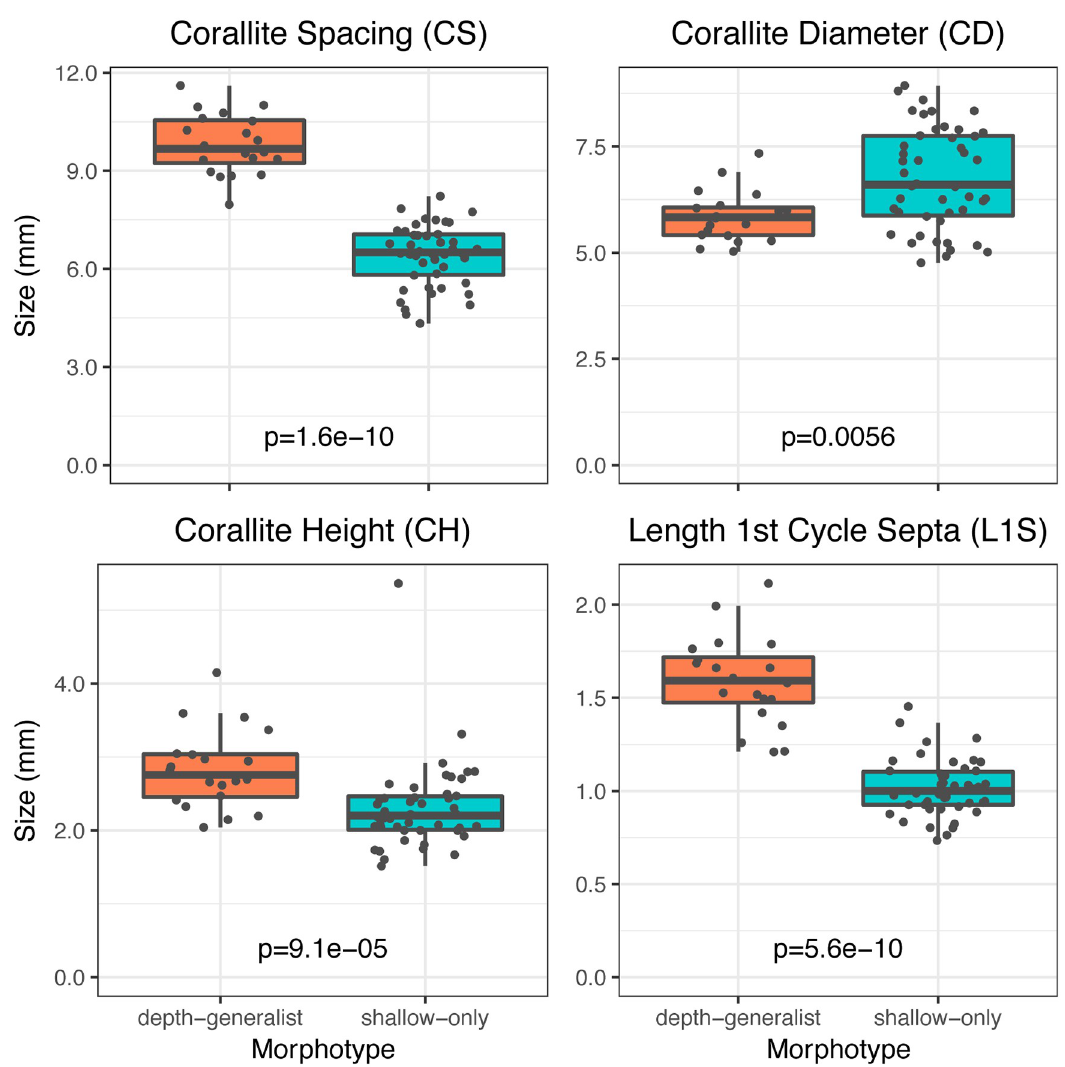
Fig 5. Morphotype sample means. Boxplots with sample overlays for corallite spacing (CS), corallite diameter (CD), corallite height (CH), and length of first cycle septa (L1S) across depth-generalist (n = 20) and shallow (n = 46) morphotypes sampled within the shallow zone of West and East FGB. Overall p values represent Mann-Whitney U tests between morphotype for each metric.